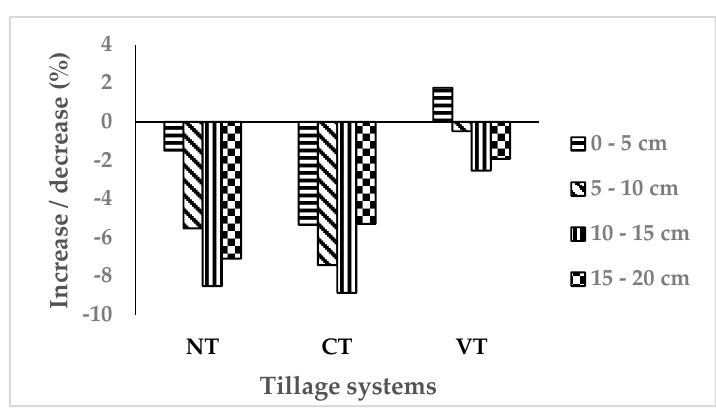
Figure 4. Changes of bulk density in 2016 compared to 2013.